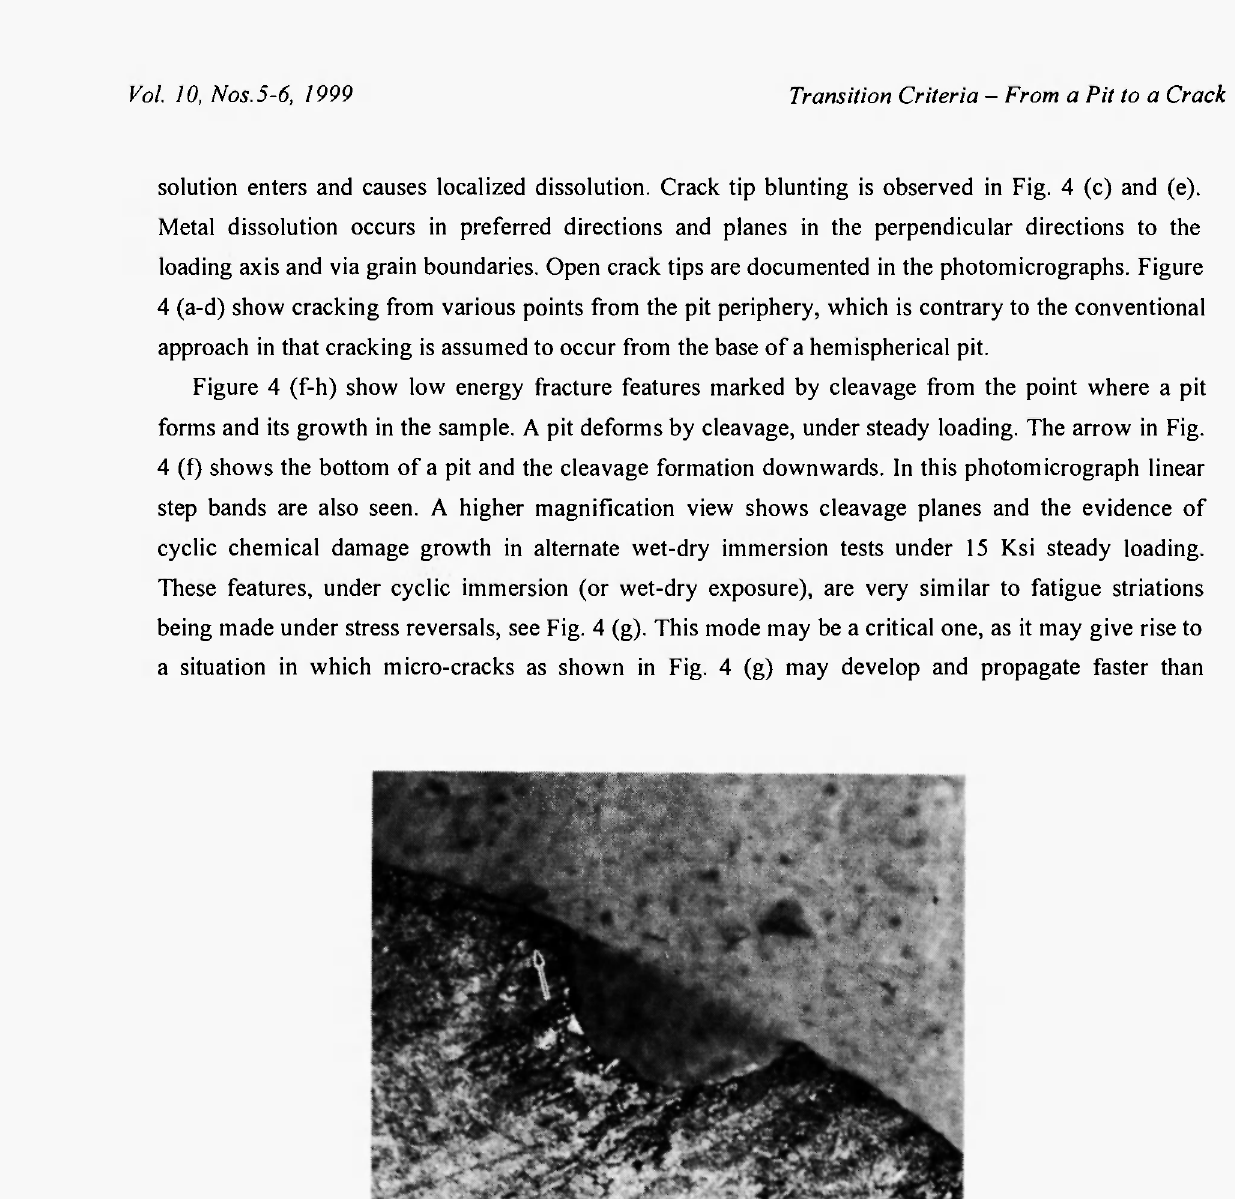
Fig. 4: Complex pit shapes in aluminum